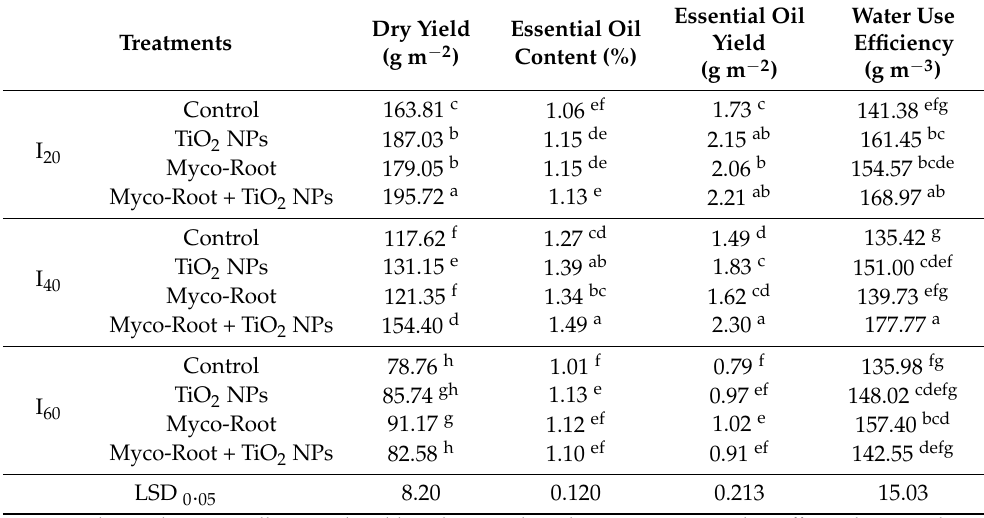
Table 4. The dry yield, essential oil content, essential oil yield, and water use efficiency of peppermint in different irrigation regimes and fertilizer